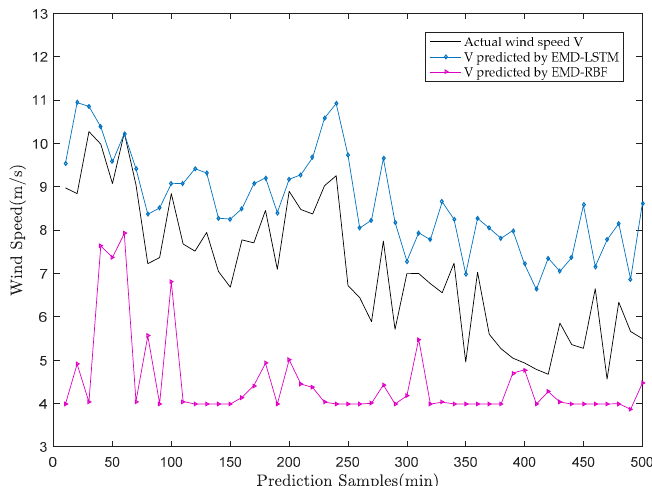
Figure 14. The results of comparison models (ESN and LSTM and VLSTM).